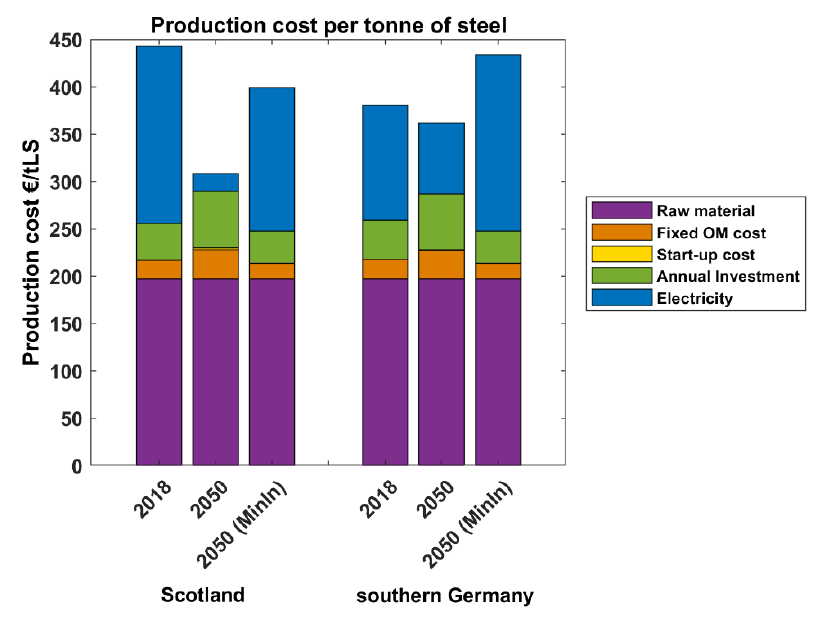
Figure 5. Steel production cost expressed per tonne of steel for the steelmaking process with the minimum investment (MinIn) level in steel production capacity (operation is at full capacity all hours of the year and no storage) in the two regions in the year 2050 (MinIn); for the modelled steelmaking process (Figure 1) for the two regions for the year 2018 and the year 2050 electricity price profiles.